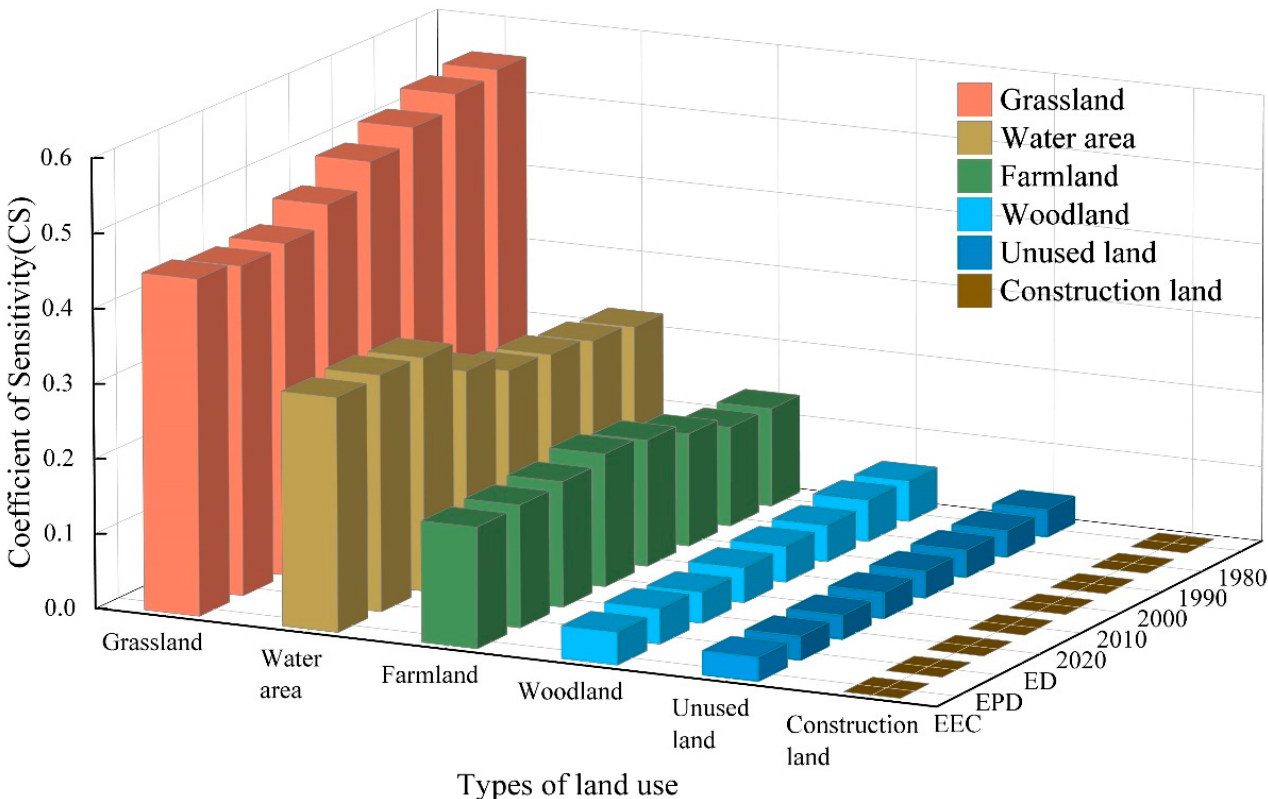
Figure 9. C oefficients of sensitivity for ESV. Figure 9. Coefficients of sensitivity for